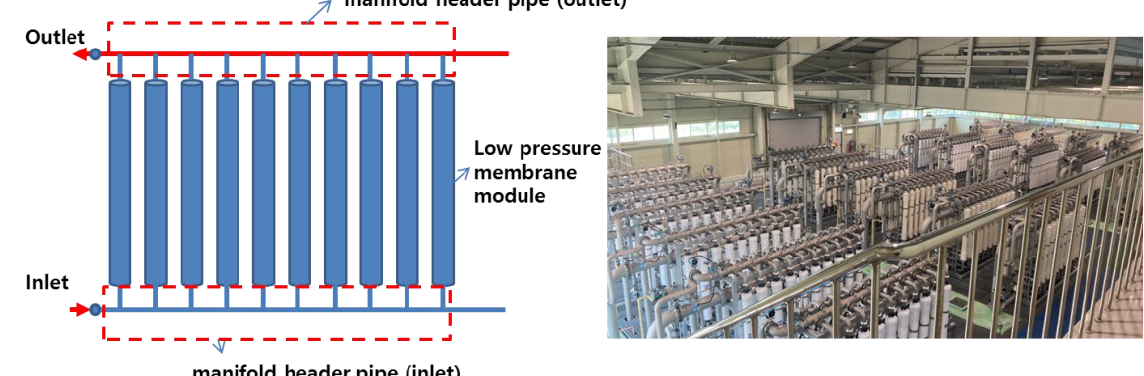
Figure 1. General parallel-arrayed low-pressure membrane module and pipes for water treatment and G drinking water treatment plant.